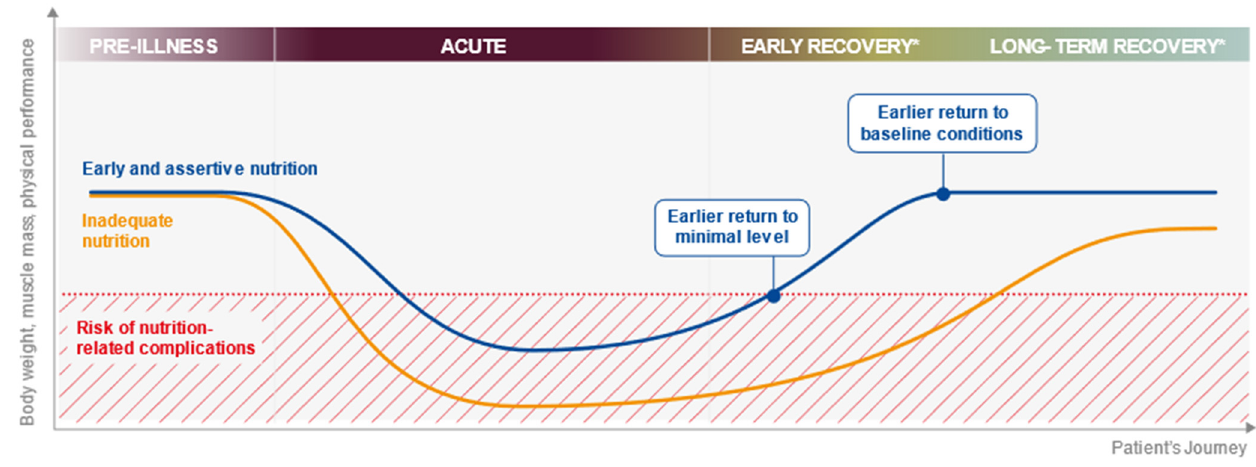
Figure 1. The impact of inadequate nutrition on the body weight, muscle mass and physical performance across the patient journey. * The early recovery period may span step-down care and ward-based care and may last from days to weeks. The long-term recovery phase (post-hospital discharge) may last for weeks or